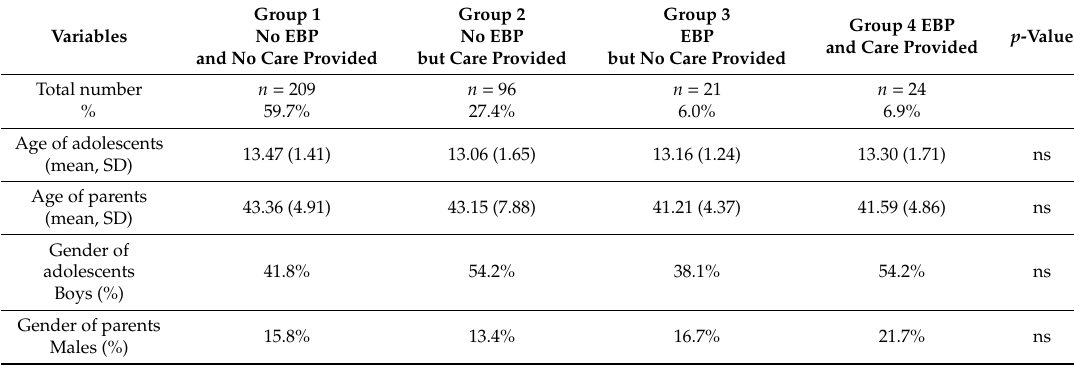
Table 1. Background characteristics of the sample by enrollment in psychosocial care and environmental and behavioral problems (EBP) (350 parents and adolescents from care sample and community sample, collected in 2017–2018).